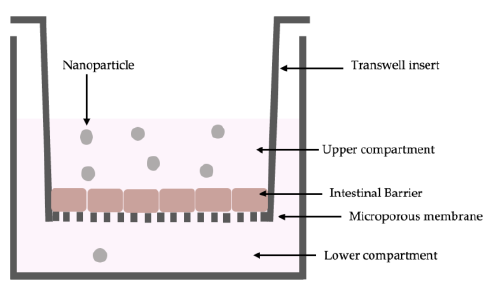
Figure 4. Schematic representation of in vitro Intestinal Barrier Model.